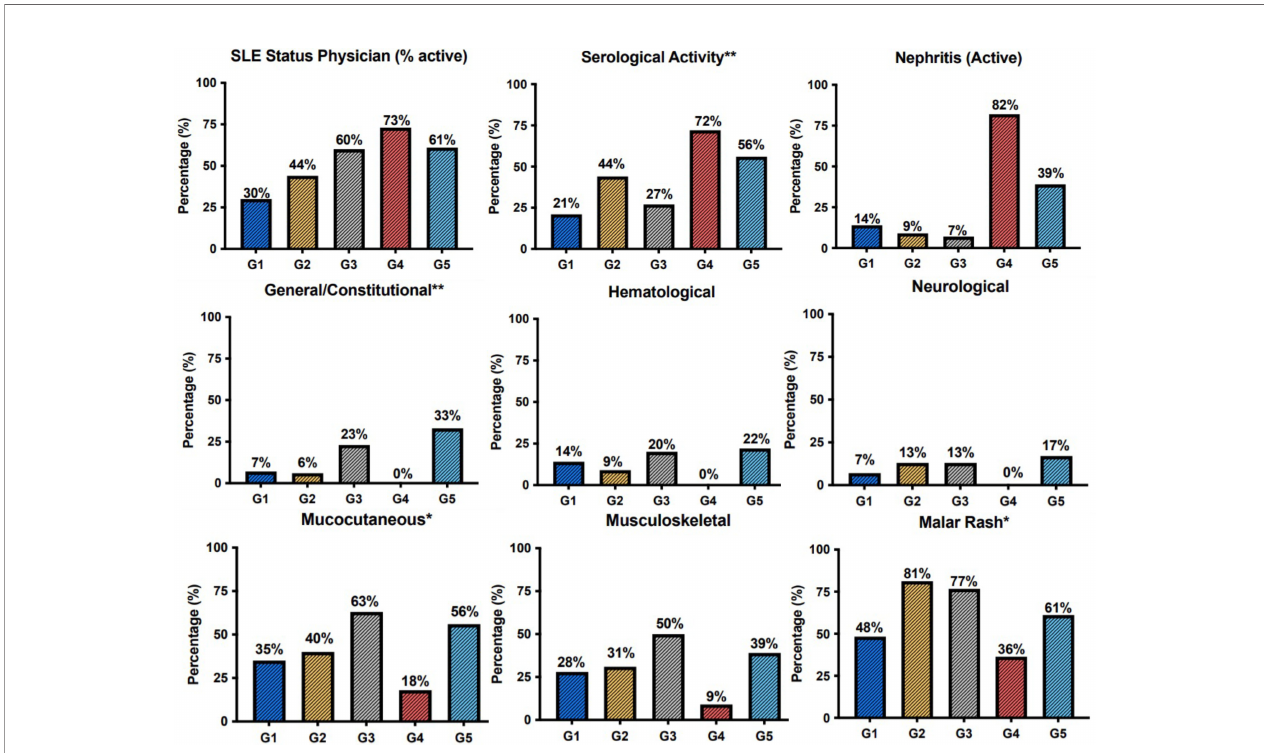
FIGURE 2 | Barplots demonstrating the prevalence of clinical features, Physician Global Assessment (SLE.status.(Physician)) and serological activity across patient groups. The G4 was de fi ned by the high prevalence of active lupus nephritis. Constitutional symptoms occurred most frequently in the G5. Mucocutaneous and musculoskeletal manifestations were more prevalent among patients of the G3. *p < 0.05; **p < 0.01 in Kruskal-Wallis test, Chi-squared